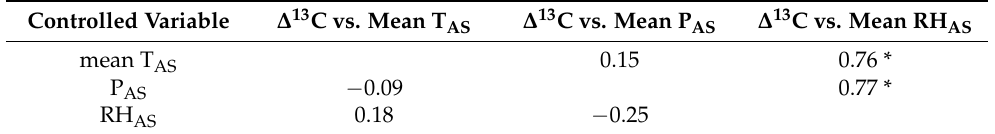
Table 3. Partial correlation analysis between the tree-ring ∆ 13 C chronology in Alaer and climatic factors from April to September (1959–2018).